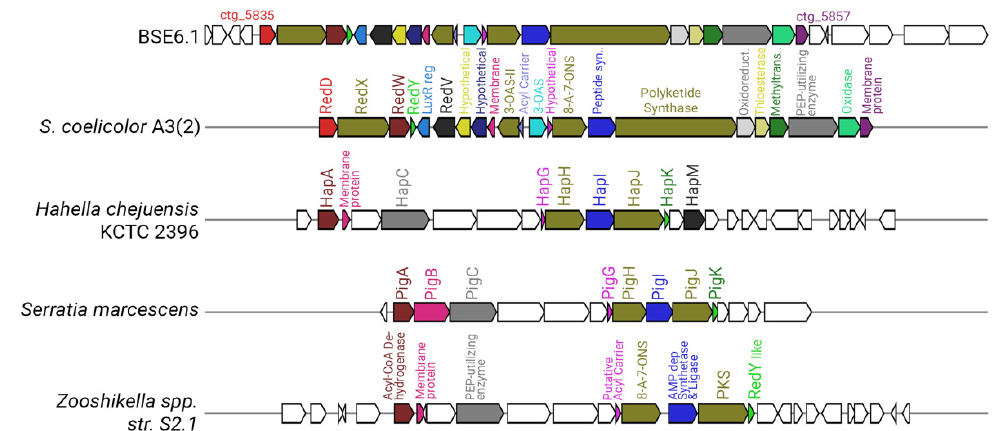
Figure 7. Comparative representation of the undecylprodigiosin cluster in BSE6.1 (cluster 10 of Supplementary Figure S2) with that of S. coelicolor A3(2), Hahella chejuensis KCTC 2396, Serratia marcescens, and Zooshikella sp. S2.1. (Genes represented without any color in the strain BSE6.1 have unknown functions, whereas those in the other species have no homologs in BSE6.1).